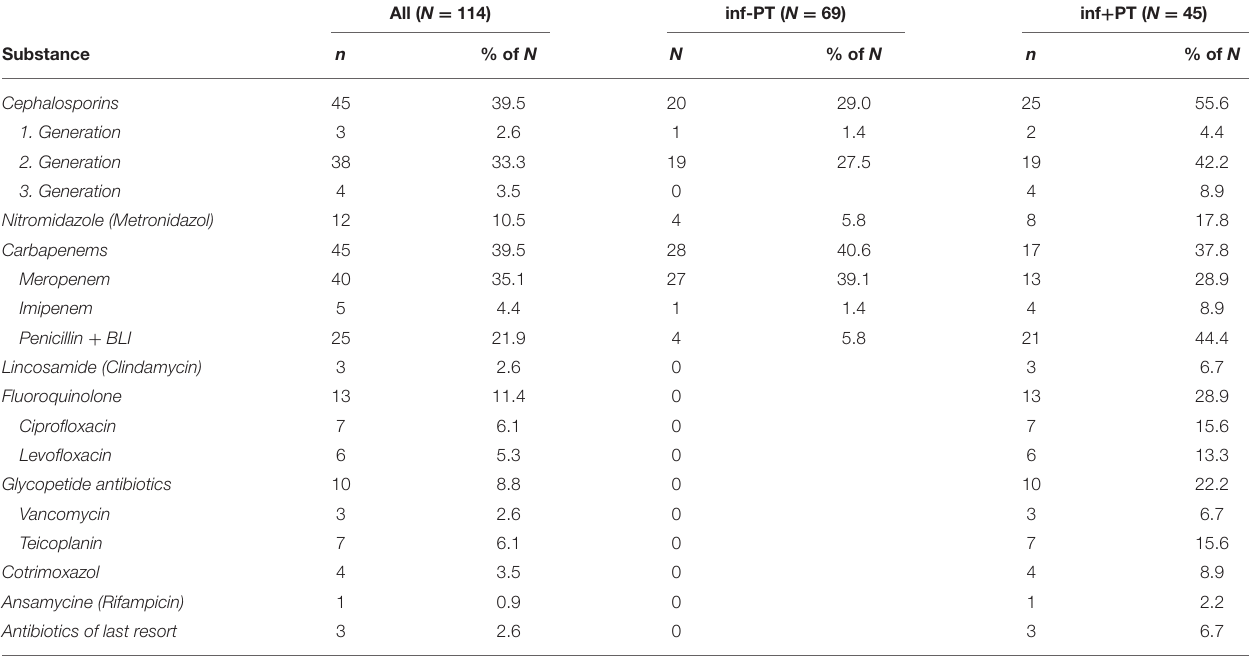
TABLE 5 | Antibiotic spectrum of anti-infective management in trauma patients. All ( N = 114) inf-PT ( N = 69) inf + PT ( N = 45)